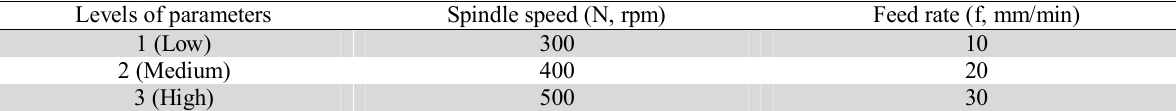
Influencing parameters & their levels Levels of parameters